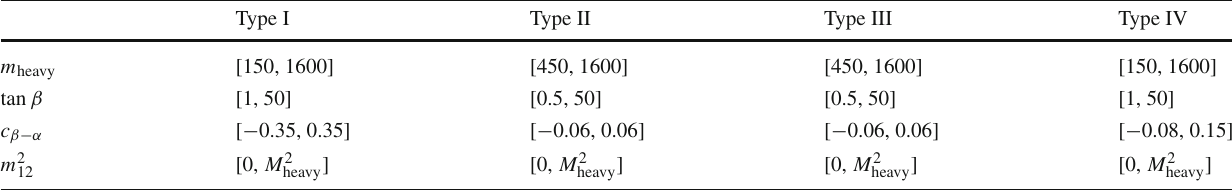
Table 3 Ranges for the input parameters of the 2HDM in our numer- ical scan. m heavy (given in GeV) refers to m ≡ m H = m A = m H ± in scenario C and to both independent masses m H and m A = m H ± in